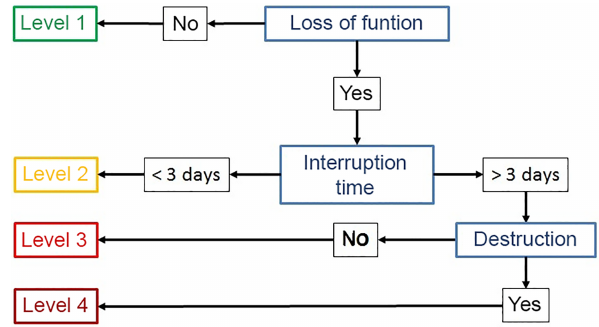
Figure 4. Illustration of the measurement scale used to assess dam- age